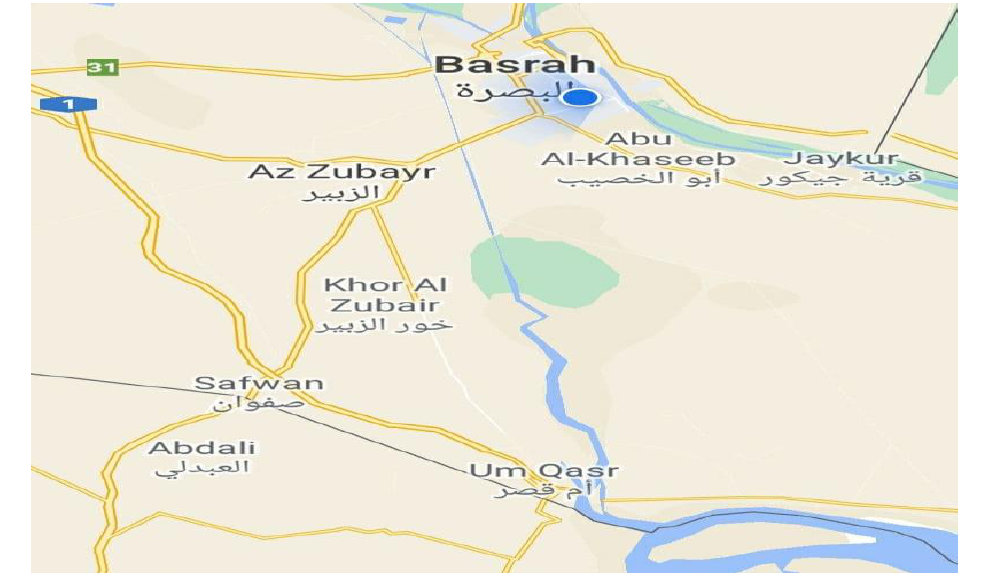
Basic boron is insoluble in water (Ballarini, et al., 2010). The aim of this research is to look at the interactions that occur during water circulation, as well as to assess the risks